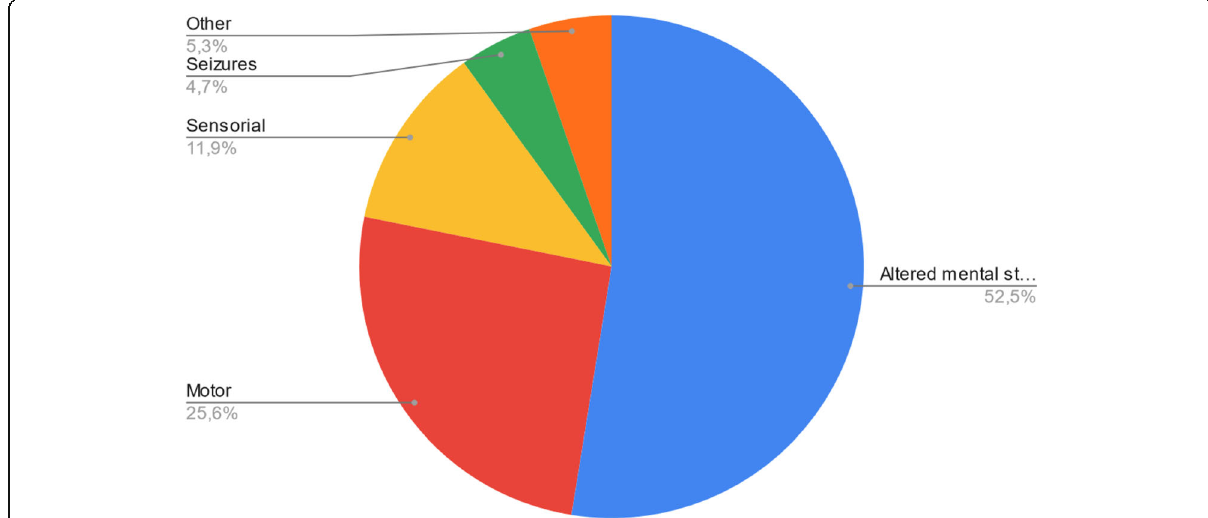
Fig. 3 Neurological manifestations in patients infected with